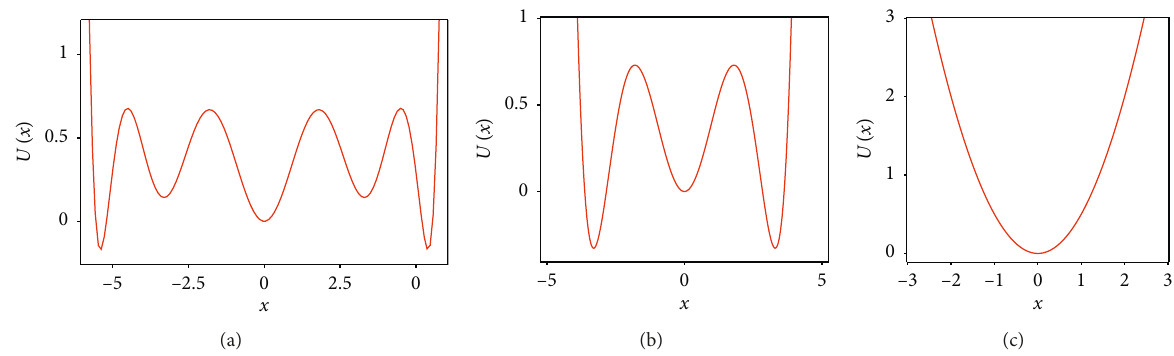
Figure 14: Potential energy functions: (a) pentastable energy harvester; (b) tristable energy harvester; (c) monostable energy harvester.